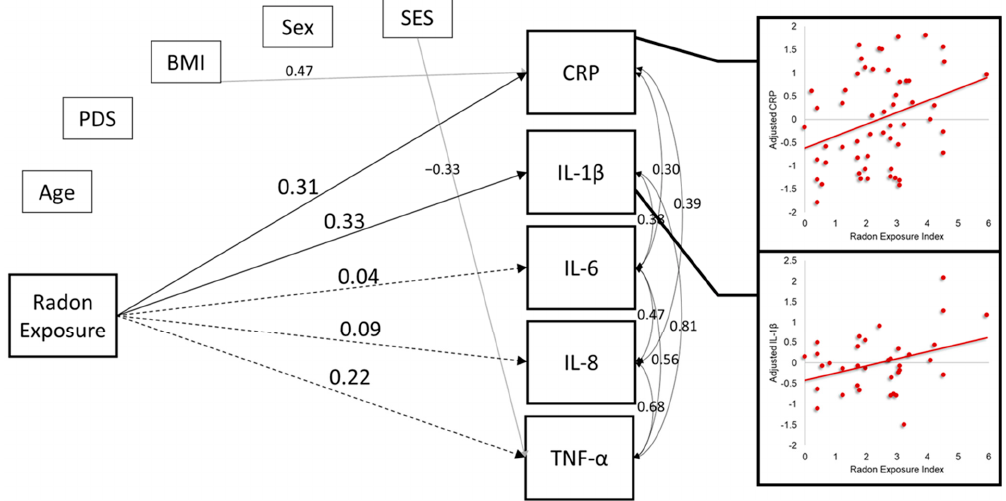
Figure 3. Model results. For simplicity, only associations of interest between radon exposure and inflammatory markers (regardless of statistical significance), and other effects significant at the p FDR < 0.05 level are shown. All inflammatory markers were natural log transformed. All parameters reported in the figure are standardized coefficients. Solid lines indicate statistically significant associations at the p FDR < 0.05 level, and dashed lines show non-statistically significant associations ( p FDR > 0.05). Scatterplots show the statistically significant associations between the radon exposure index and natural log transformed CRP (top), and IL-1 β (bottom) after adjusting for the effects of age, sex, pubertal development, BMI, and SES. Sex was dummy coded as 0 = “male”, 1 = “female”. “BMI” = body mass index; “CRP” = c-reactive protein; “IL” = interleukin; “PDS” = pubertal development stage; “SES” = socioeconomic status; “TNF- α ” = tumor necrosis factor alpha. Scatterplots of significant associations between radon exposure and inflammatory markers.